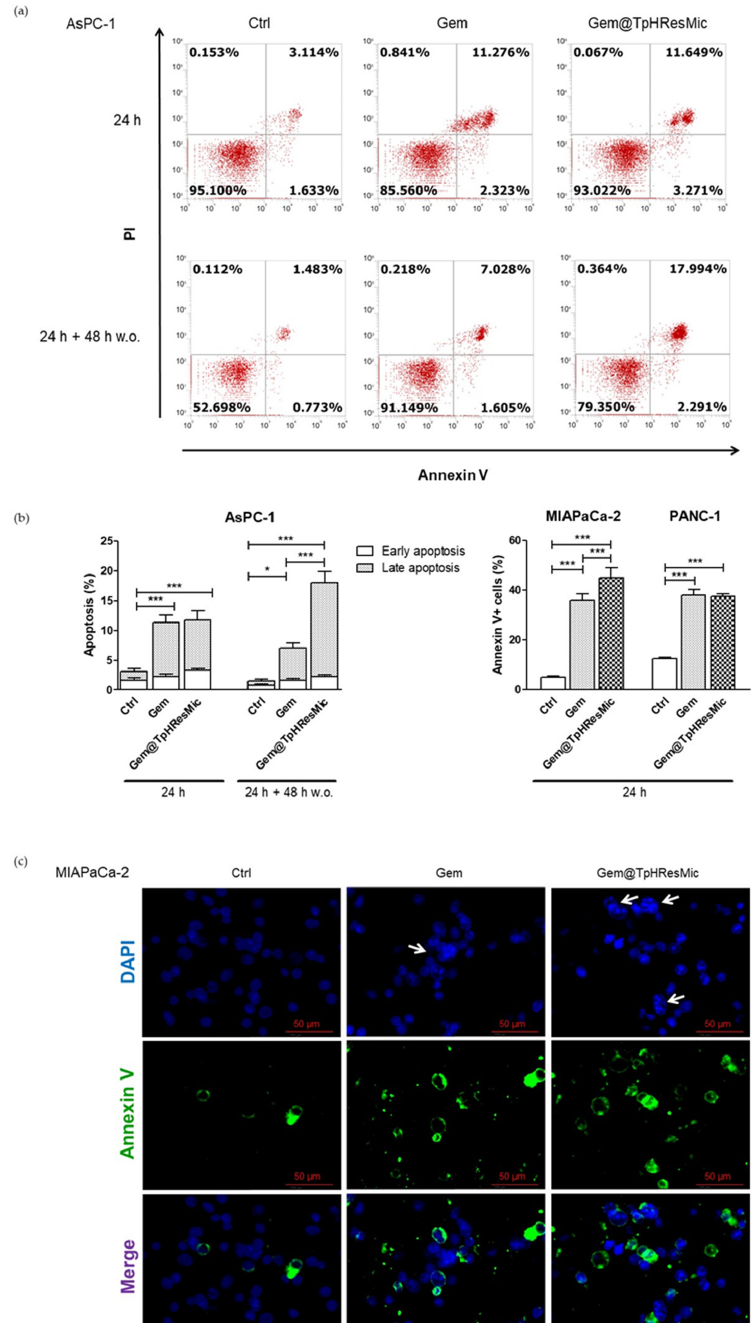
Figure 14. Evaluation of induction of apoptosis in PDAC cell lines treated with Gem and Gem@TpHResMic. ( a ) Representative dot plots showing FCM analysis in AsPC − 1 cell line. ( b ) Bar graphs summarizing the results of the assays, as the mean ± SD of the three independent experiments (* p < 0.05, *** p < 0.001). ( c ) Representative IF images of the MIAPaCa-2 cell line, showing nuclei features (white arrows show polynucleated cells) and Annexin V-positive cells (blue—DAPI-stained nuclei; green—Annexin